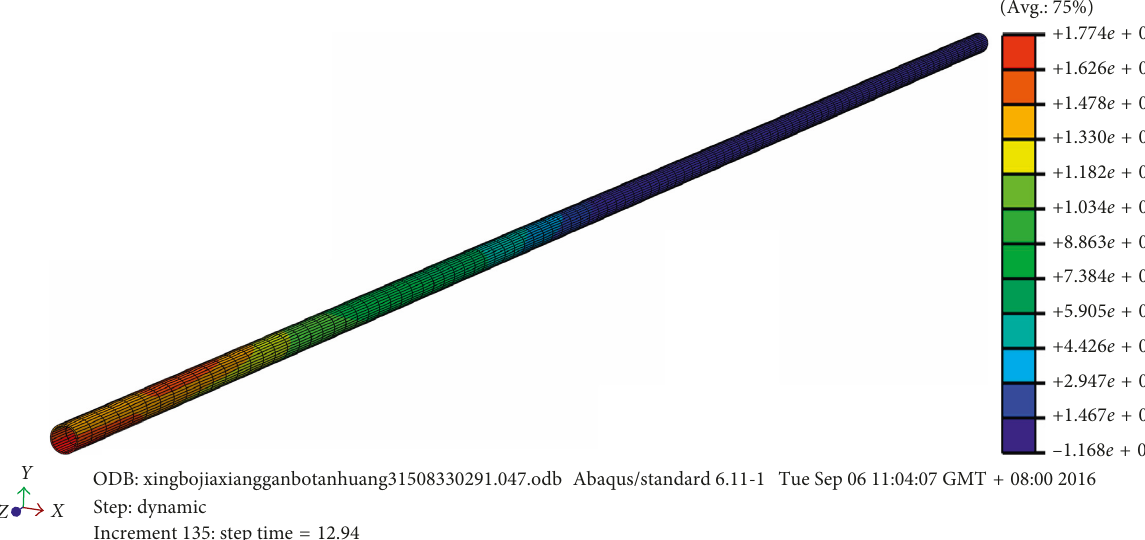
S , max. principal (Avg.: 75%)